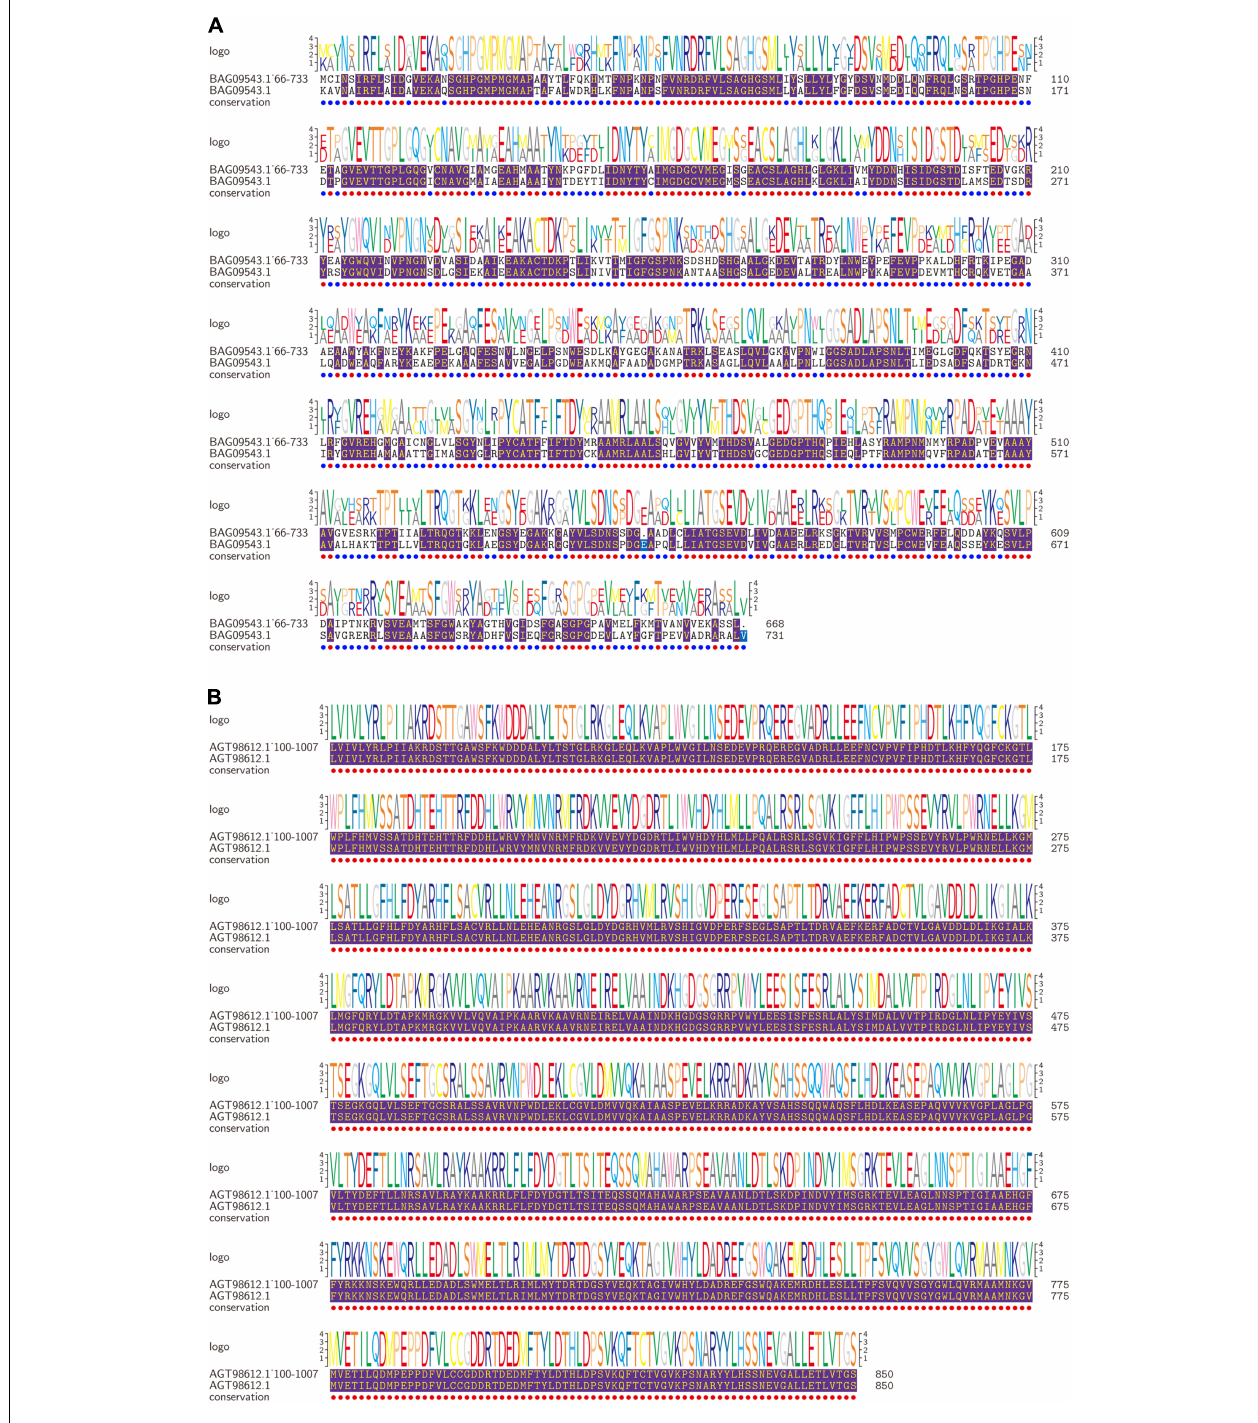
FIGURE 4 | Proteins amino acid residues of predicted motifs comparison. The first layer is NeoPyropia protein, and second layer is target protein. The purple part is sequence homology ( A: Transketolase; B: Trehalose-6-phosphate synthase).